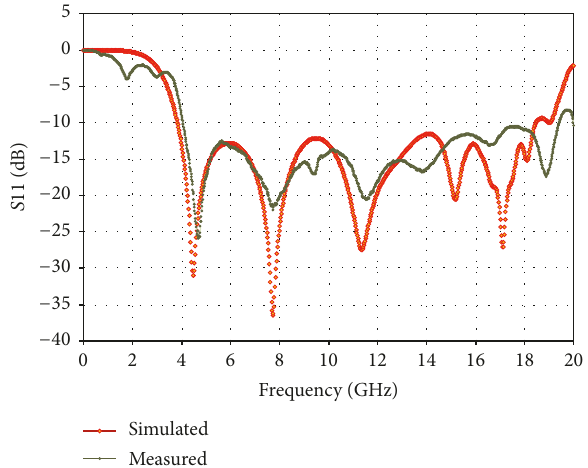
Figure 6: Results of measured and simulated values of 𝑆1 1 for the proposed antenna.